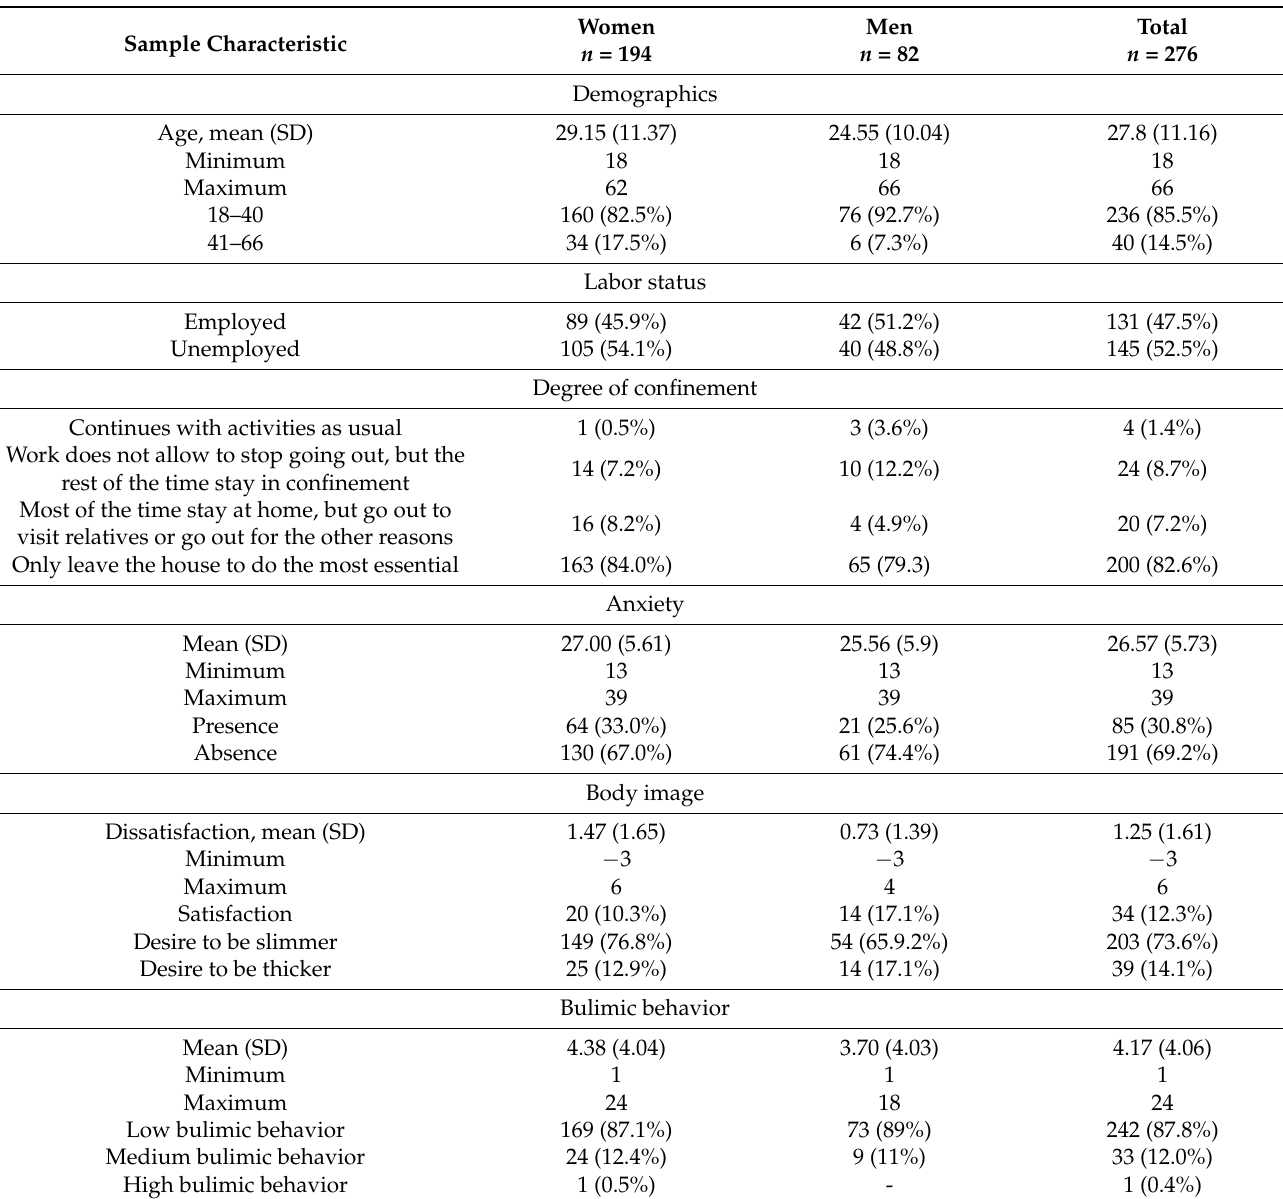
Table 1. Sample characteristics grouped by gender. Variable distributions are reported as a n (%) unless otherwise specified. Sample